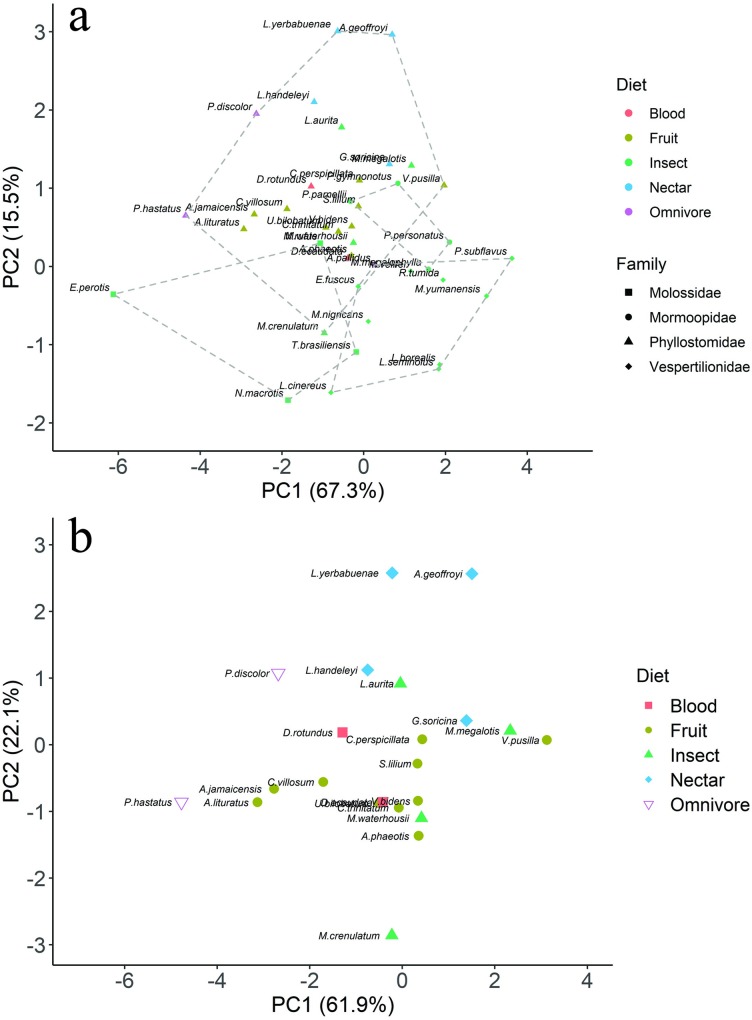
Ordinations of the first and second components of the phylogenetic principal component analysis (pPCA).pPCA results for the full dataset (a) and just Phyllostomidae (b). Dotted lines for the full dataset delineate minimum convex hulls for each family.